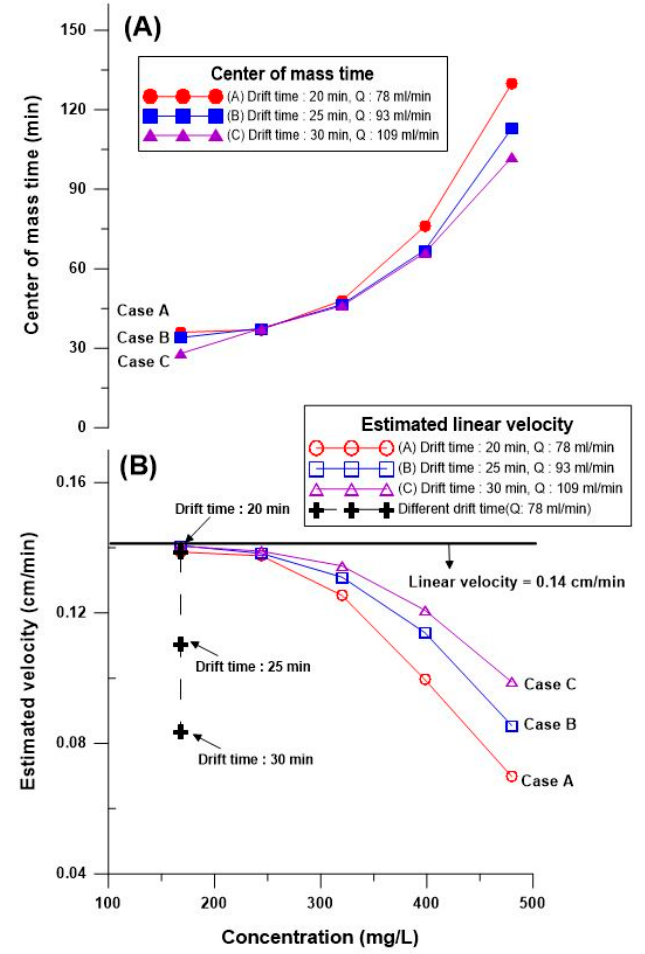
Figure 5. Center of mass time (t com ) and estimated linear velocity from the varied input tracer concentration (Br) for fifteen cases (case A: 20 min of drift time, case B: 25 min of drift time, case C: 30 min of drift time).